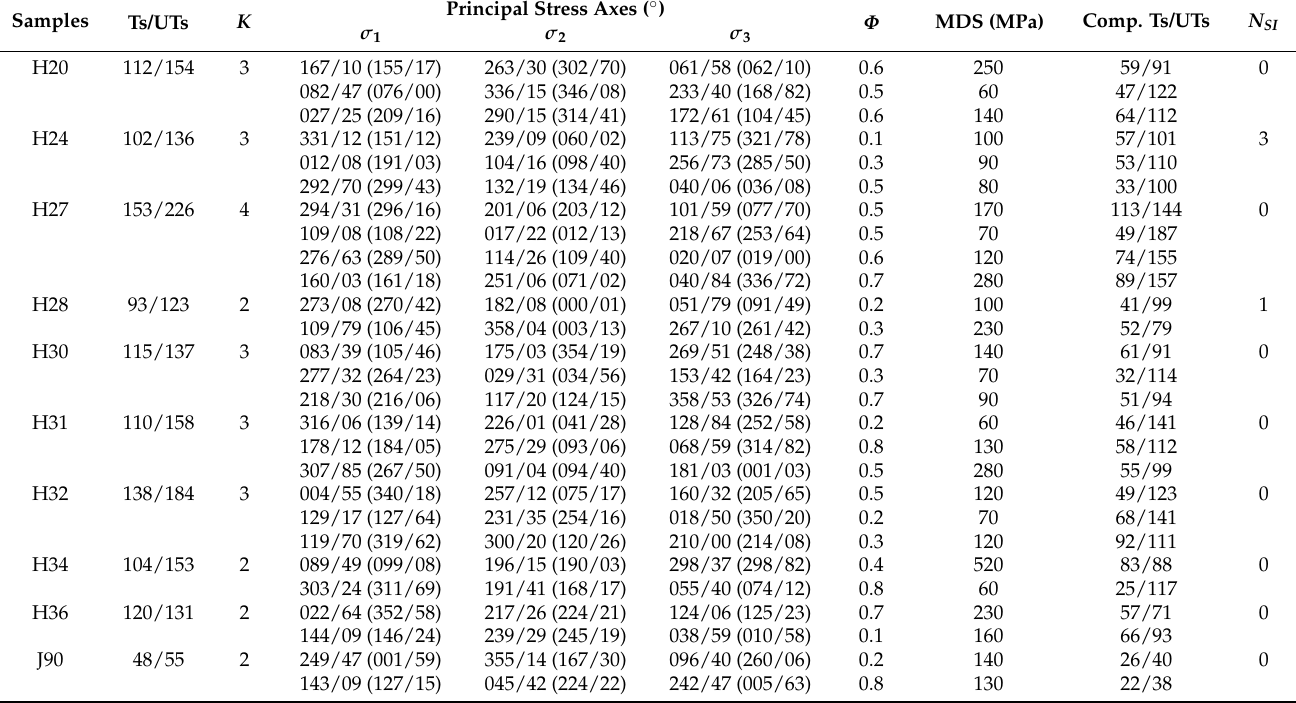
Figure 8. Lower-hemisphere, equal-area projections of calcite c-axes, twinned and untwinned e-planes for ( a – c ) thick twins and ( d – f ) thin twins from sample H36. Each twinned or untwinned e-plane is symbolized by a short line at the pole to the e-plane, with an arrow directed toward the gliding or potentially gliding direction. Table 2. Stress results by applying the improved version of Shan et al.’s (2019) method to calcite thick-twin datasets measured for samples from the Longshan Dome. σ 1 , σ 2 , and σ 3 represent the orientations (bearings and plunges) or magnitudes of the maximum, intermediate, and minimum principal stresses. Their orientations in the untilted state are bracketed. K is the phase number. Ts and UTs are twinned e-planes and untwinned e-planes. The stress ratio, Φ , is defined as ( σ 2 – σ 3 )/( σ 1 – σ 2 ). MDS is the maximum differential stress, σ 1 – σ 3 . N SI is the number of incompatible (twinned and untwinned) e-planes to all